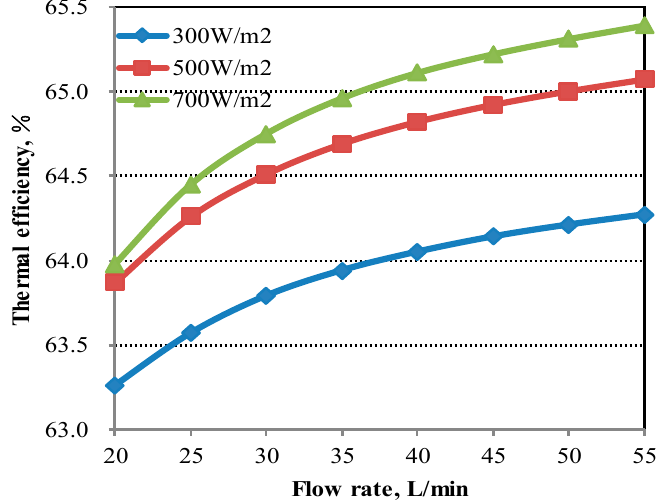
Figure 6. Variations in heat collecting efficiency of the LS-2 PTC with the different DNI and HCO flow rate (the inlet temperature of the HCO is 151 °C ).